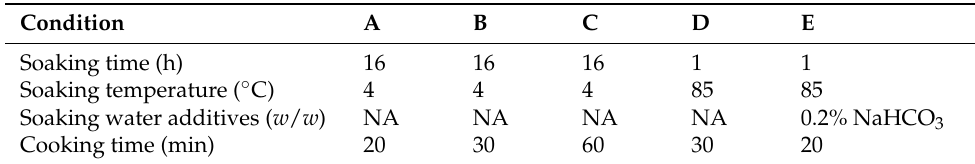
Table 1. Aquafaba production